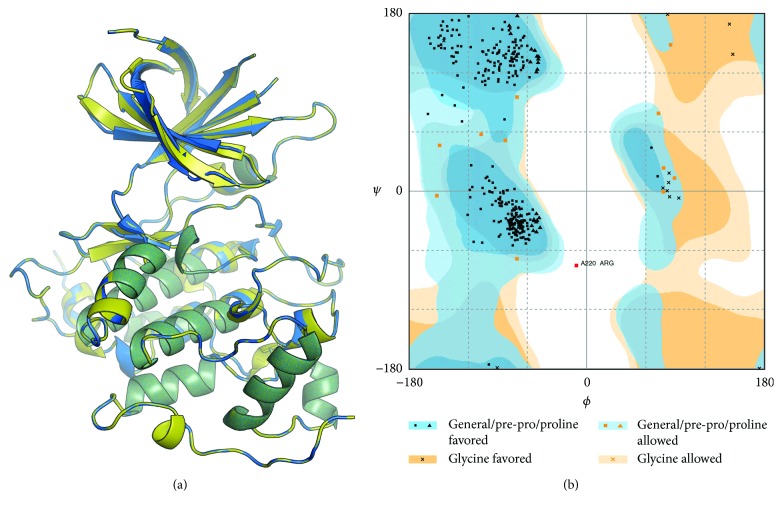
Comparative modeling of GSK3α using the crystal structure of GSK3β (PDB: 1Q41). (a) Molecular superimposition of GSK3α and GSK3β. Crystal structure of GSK3β and modeled GSK3α were shown in blue and yellow. (b) Ramachandran plot of the modeled GSK3α.